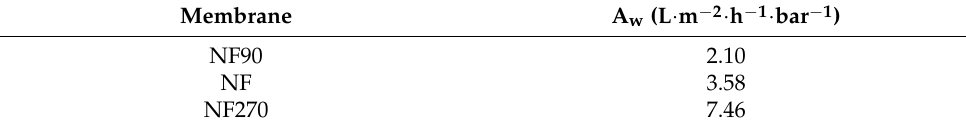
Table 3. Clean water permeability value for nanofiltration membranes (dead-end module).